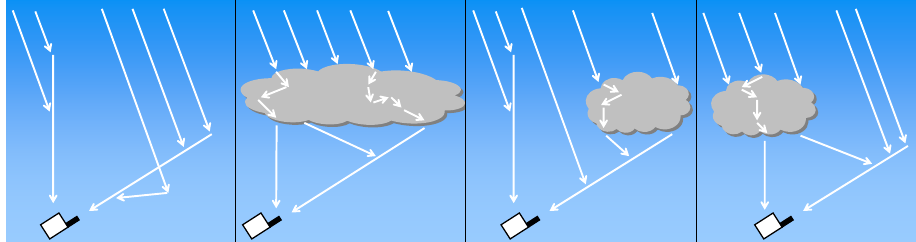
Figure 1. Schematic of MAX-DOAS measurement for four different conditions of cloudiness: cloud free, cloud covered, a cloud at 30 ◦ elevation only, and a cloud only in the zenith direction. The MAX-DOAS differential slant NO 2 column measurement is derived from measurements in these two directions, both done within